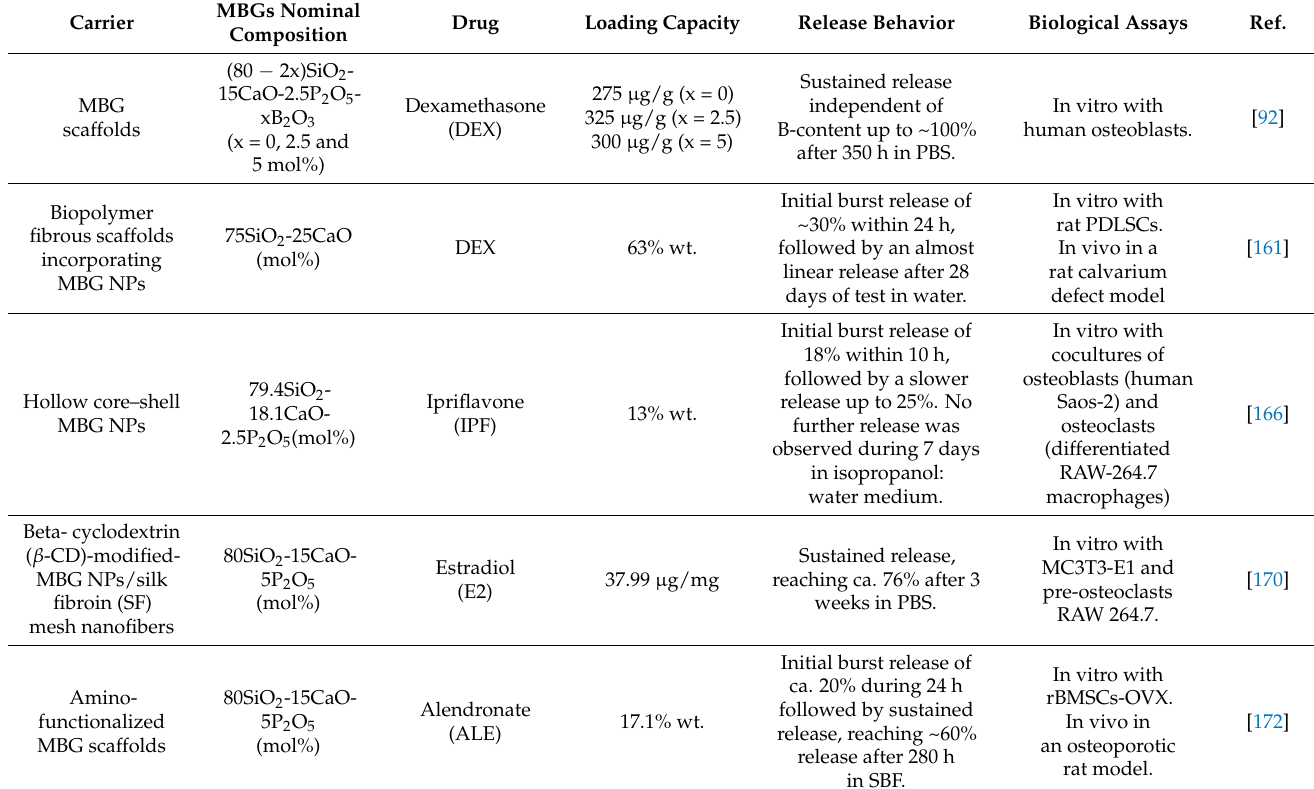
Table 2. Summary of MBG-based delivery systems of osteogenic and anti-antiosteoporotic